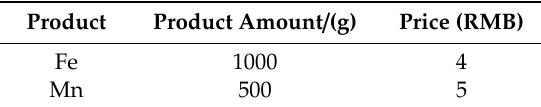
Table 2. The price of